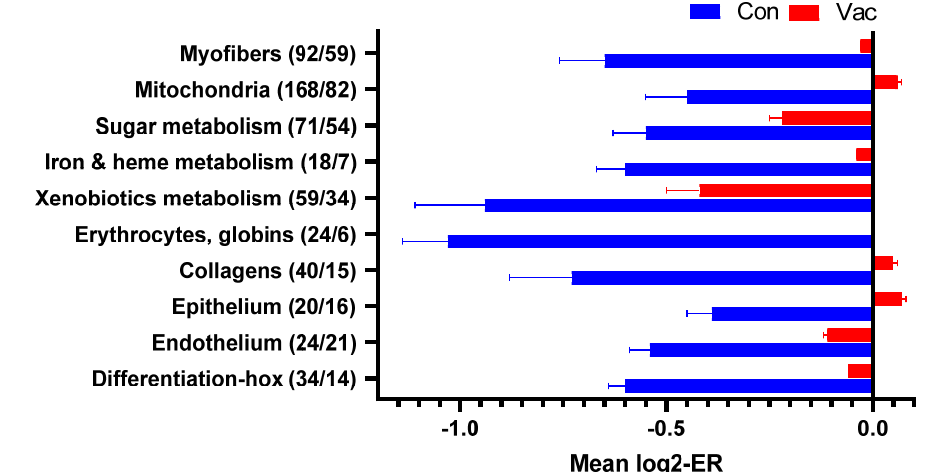
Figure 5. Functional groups of genes with coordinated expression changes in hearts of SAV- challenged Atlantic salmon at 21 dpc in vaccinated fish (vac) versus unvaccinated controls (con). The numbers of differentially expressed genes are in parentheses (saline control/vaccinated). Data are mean log2-expression ratios (infected to intact control) ± Standard Error. All differences between vaccinated fish and saline control are significant.